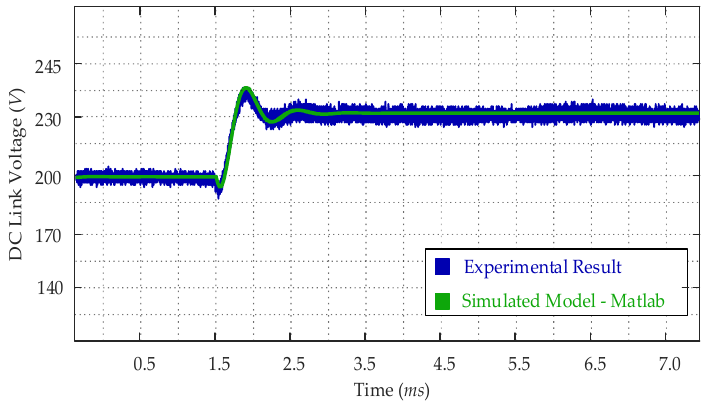
Figure 9. Validation of the converter model on the discharging mode (step-up mode).